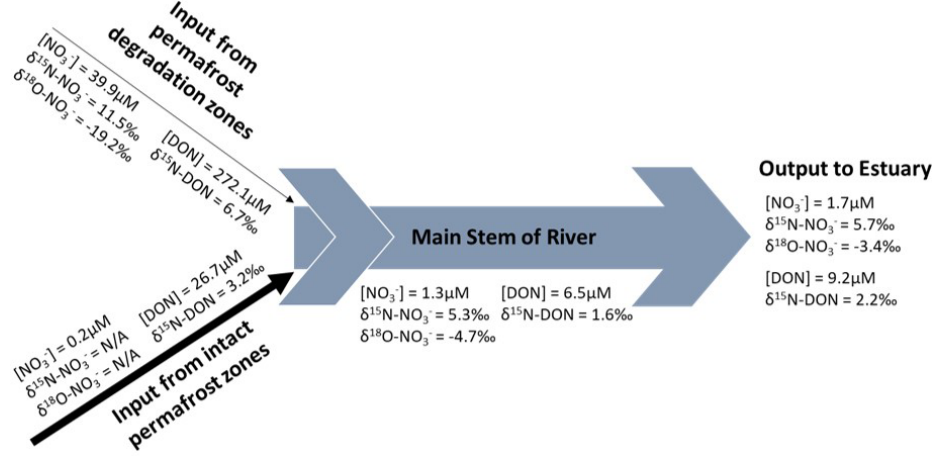
Figure 5. Summary of concentration and isotopic signals of nitrate and DON species in the Kolyma system. Data displayed are average values of all samples in each zone of the